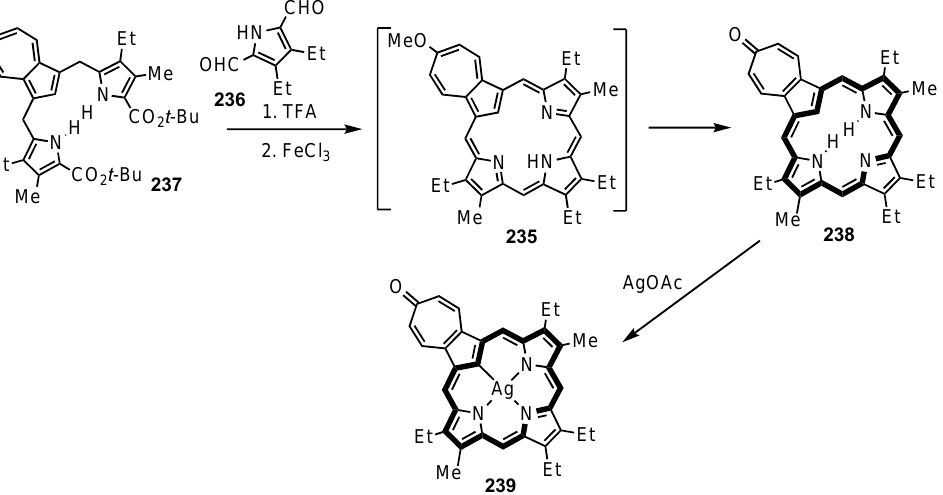
Scheme 38. Synthesis and metalation of a tropone-fused